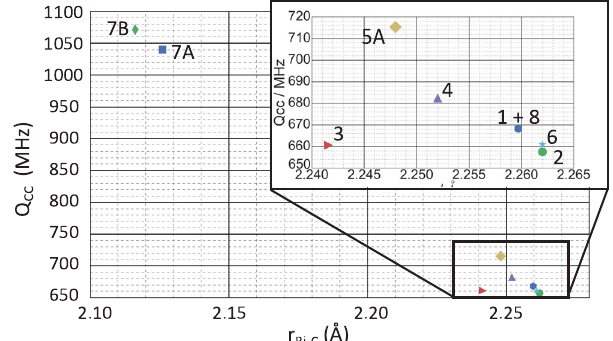
FIG. 6. Q cc versus average Bi ─ C bond length. A trend for the investigated Bi-aryl compounds can be observed: The closer the Bi ─ C distance, the higher Q cc